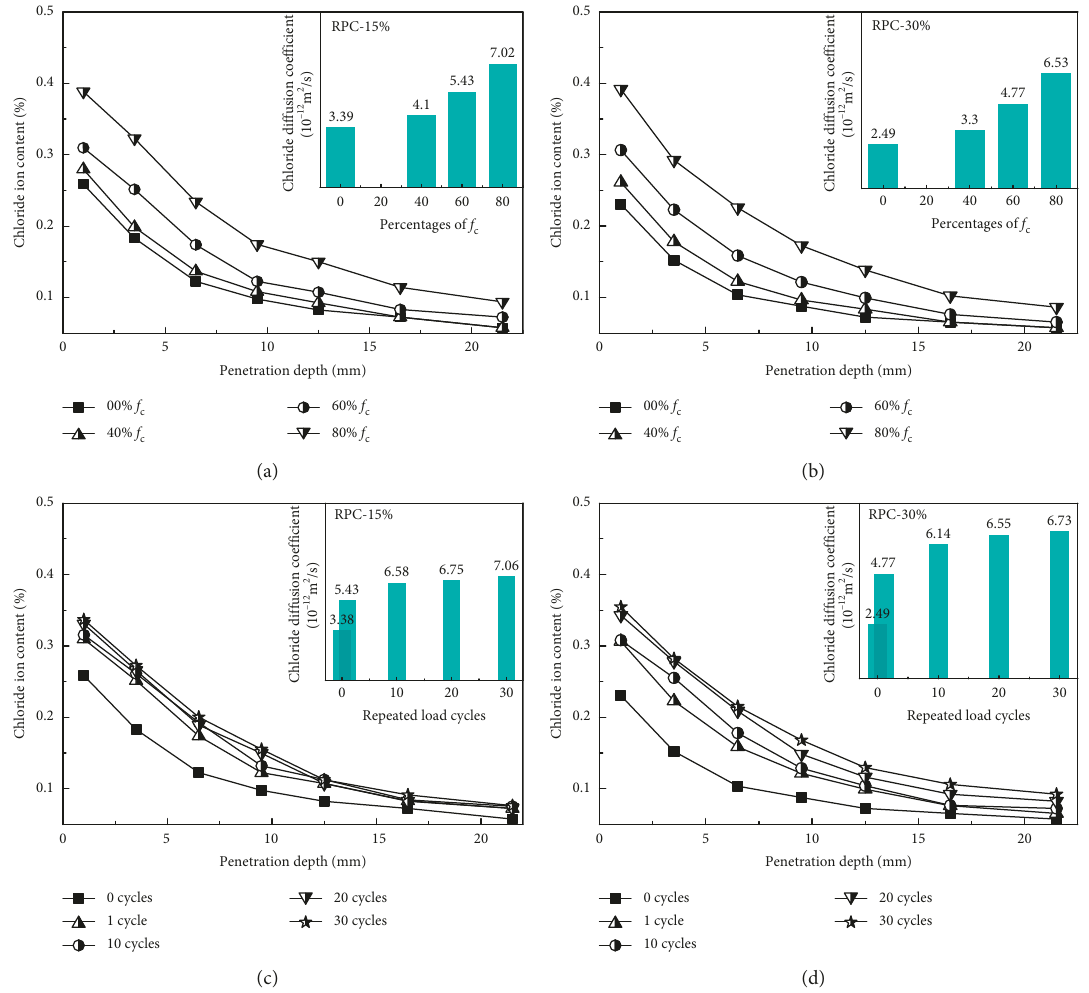
Figure 11: Chloride content curves of RPC after various loads have been applied. (a) RPC-15% and (b) RPC-30% after various levels of sustained load. (c) RPC-15% and (d) RPC-30% after various cycles of repeated